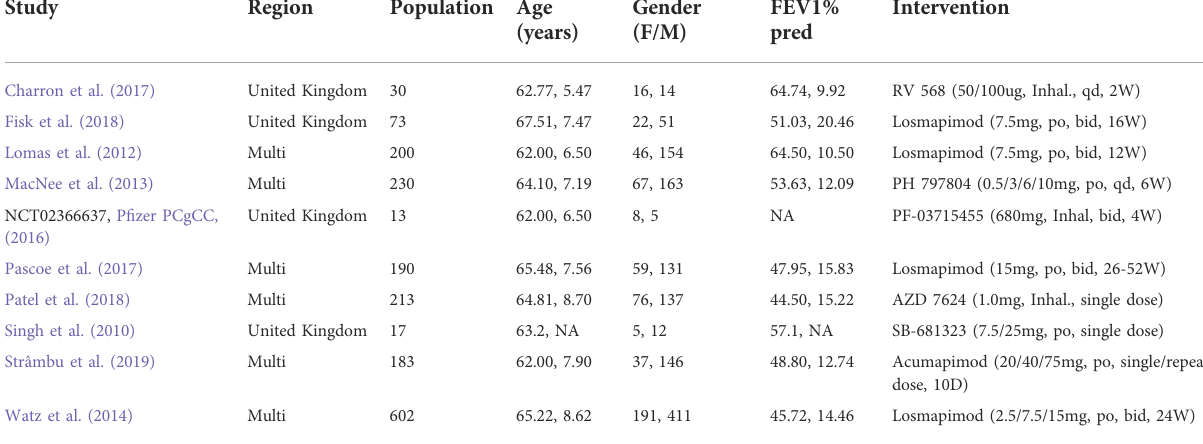
TABLE 3 Characteristics of the included